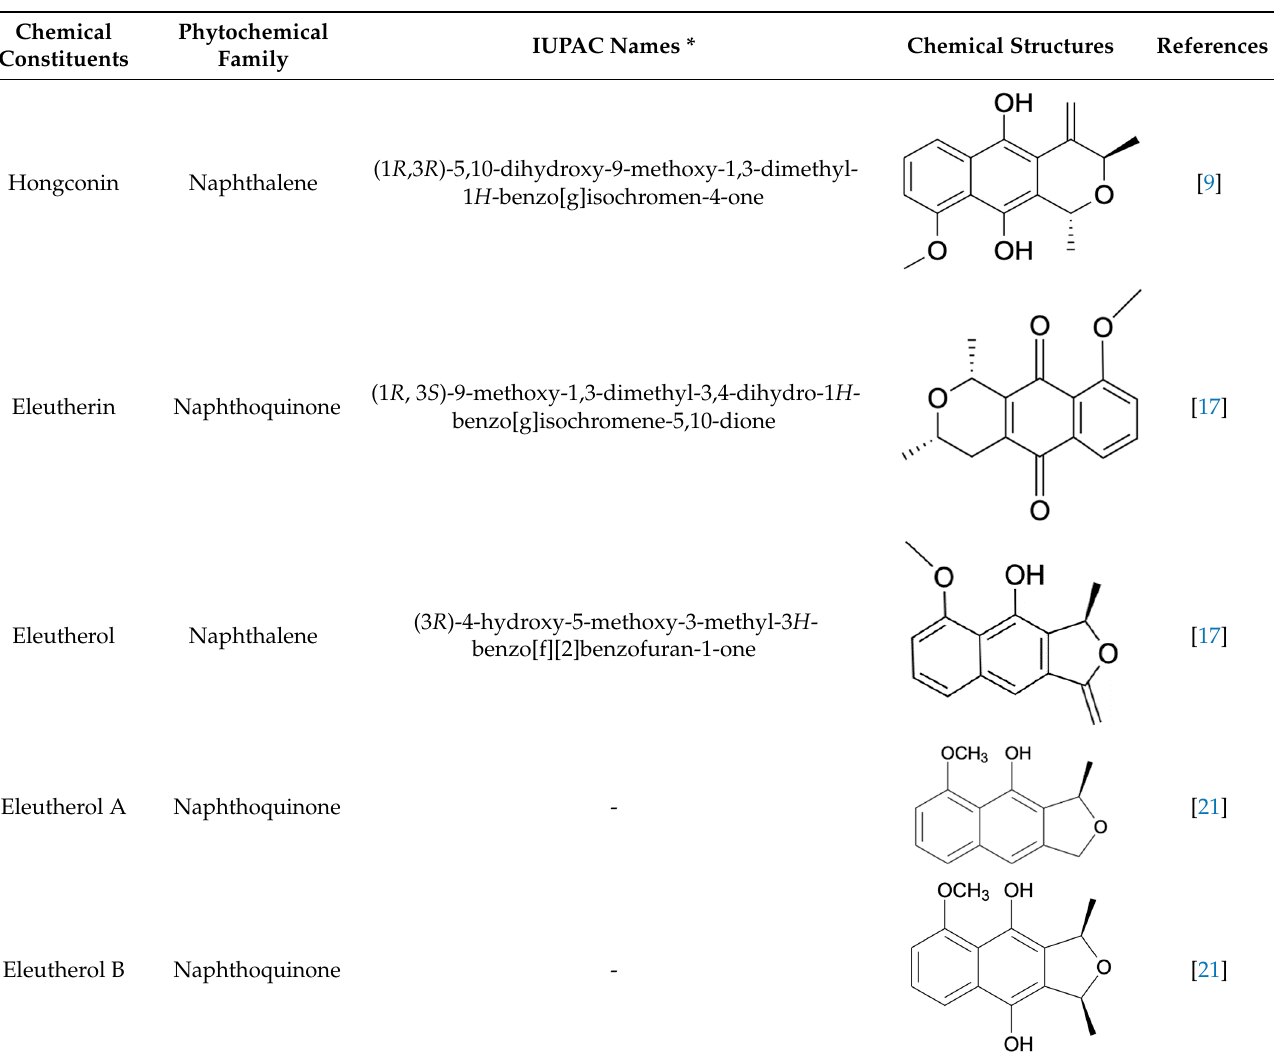
Table 1. Chemical constituents isolated from Eleutherine bulbosa (Mill.) Urb. bulb.